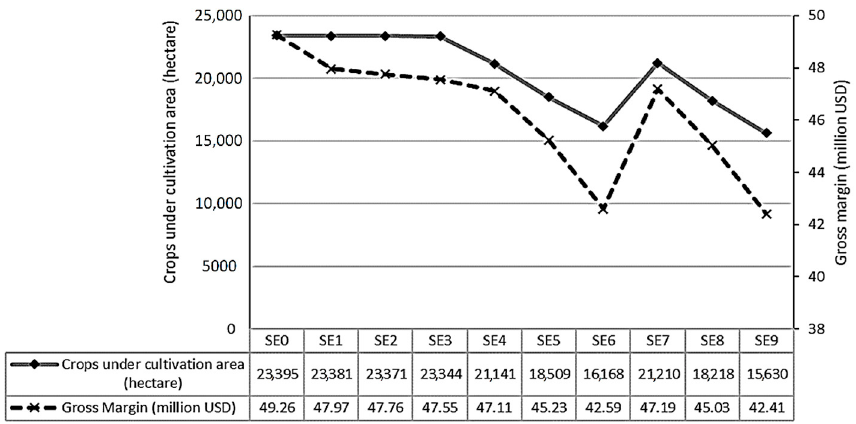
Figure 6. Comparing land use and gross pattern return under different scenarios.